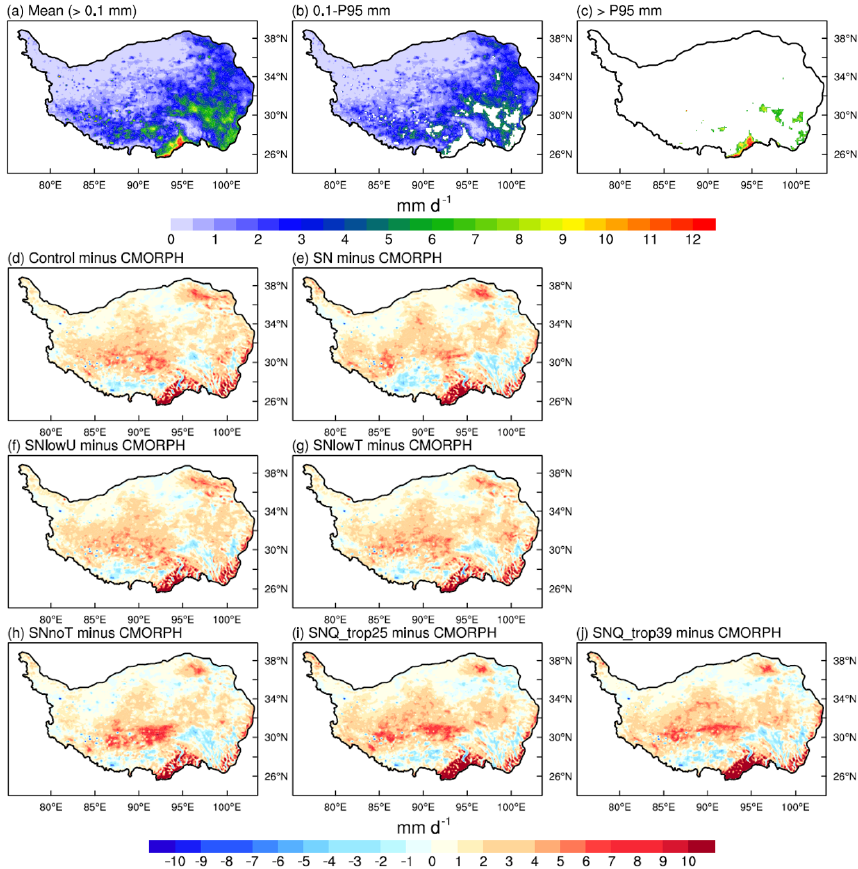
Figure 2. Spatial distribution of the mean and difference between, precipitation (mmd − 1 ) fields for July 2008. (a) CMORPH, (b) CMORPH precipitation smaller than P95 (5.73mmd − 1 ), and (c) CMORPH precipitation larger than P95. Differences between CMORPH and (d) con- trol, (e) SN, (f) SNlowU, (g) SNlowT, (h) SNnoT, (i) SNQ_trop25, and (j) SNQ_trop39. The bold solid black lines denote the boundary of the